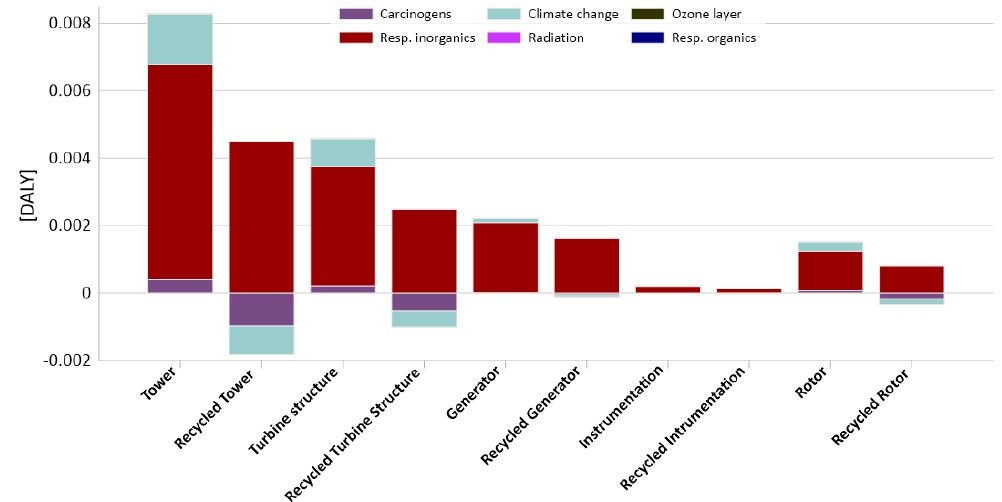
Figure 7. Results of characterization of environmental impacts occurring during the life cycle of elements of the construction of an innovative wind power plant comparison of results with and without recycling for the human health categories.